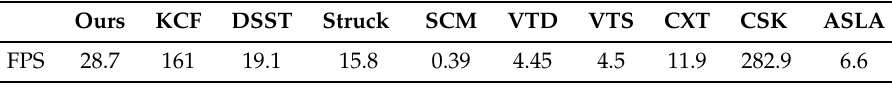
Table 1. The speed comparison of different algorithms.